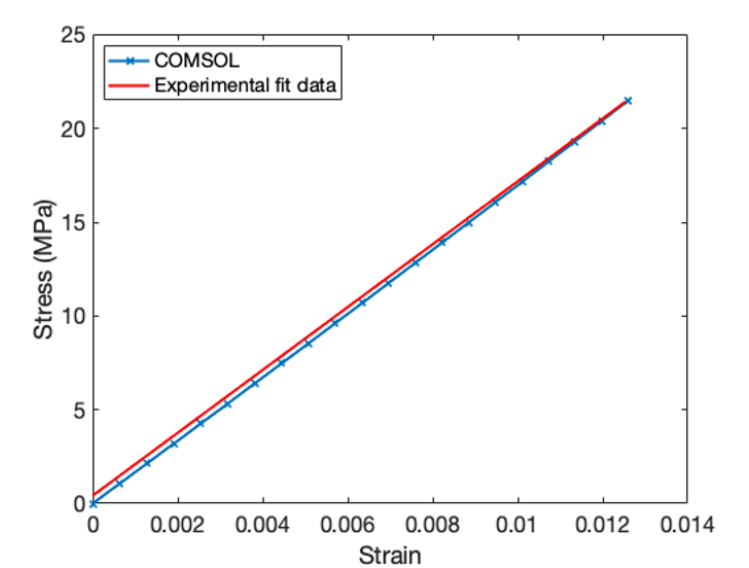
Figure 8. Validation of the SMP material subroutine stress prediction from the simulation (blue colour) with experimental uniaxial tensile test data (red colour) at room temperature with an applied load of 2330.95 N.